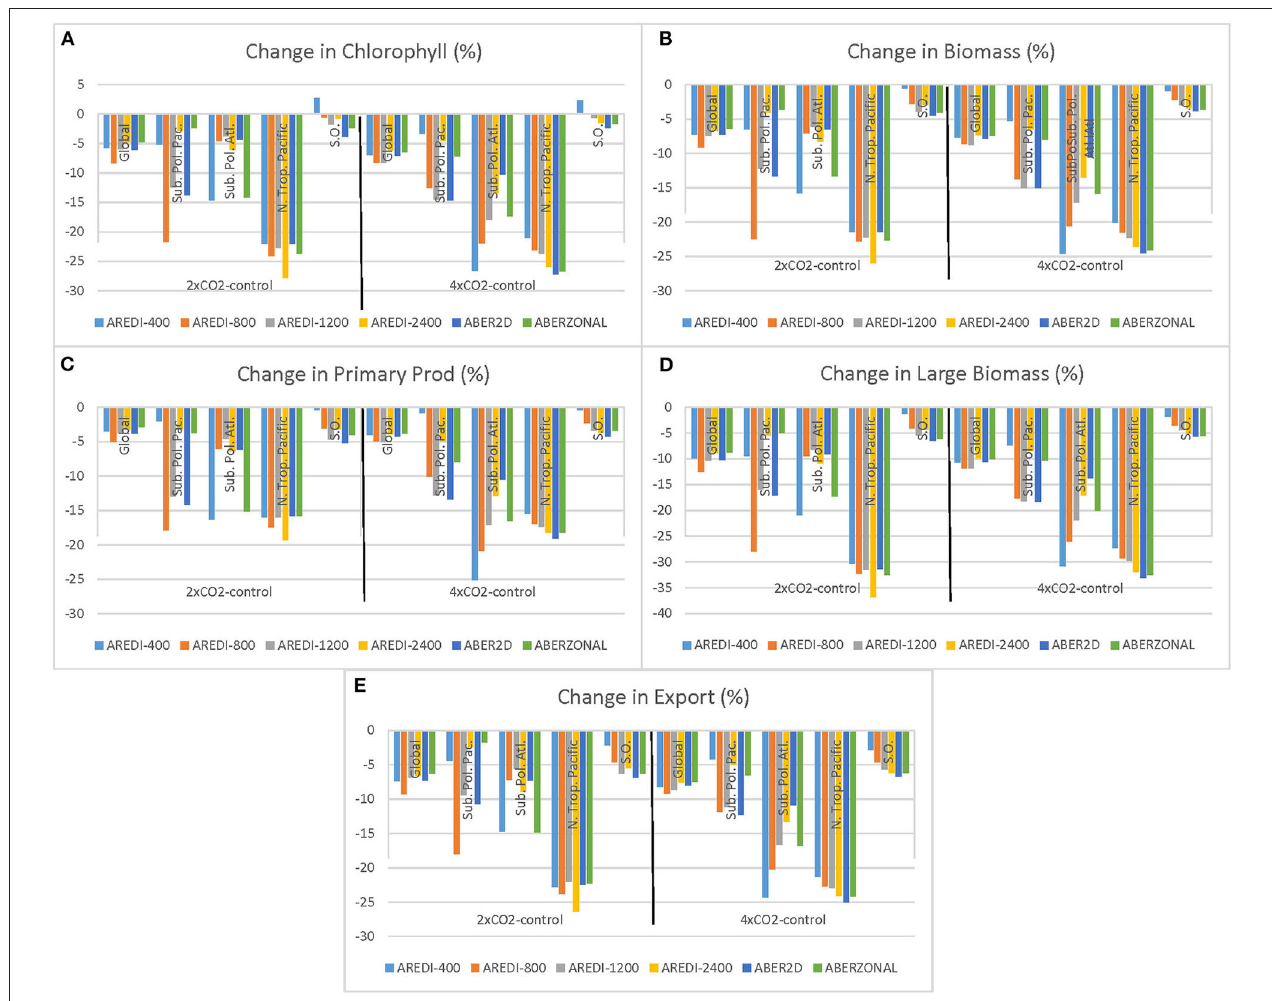
FIGURE 5 | Summary of changes in biological variables across models and scenarios. Each plot shows the relative change in % for (A) Chlorophyll, (B) Biomass, (C) Primary Production, (D) Large Biomass, and (E) Export. Each plot is divided into results from 2xCO 2 simulations (left half) and ½ the change under the 4xCO 2 simulation (right half). Each cluster of bars shows changes in a particular region across models (colors denote different distributions of A REDI ). Clusters from left to right within each half plot show the global integral, the Subpolar North Pacific from 40 to 60 ◦ N, the Subpolar North Atlantic from 40 to 60 ◦ N, the Northern Tropical Pacific (10-25 ◦ N, site of the largest drops in biological variables in Figure 8 ), and the Southern Ocean (70-50 ◦